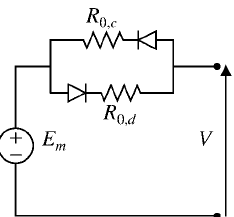
Figure 4. Simplified Thévenin equivalent circuit model of the battery (see text for details).